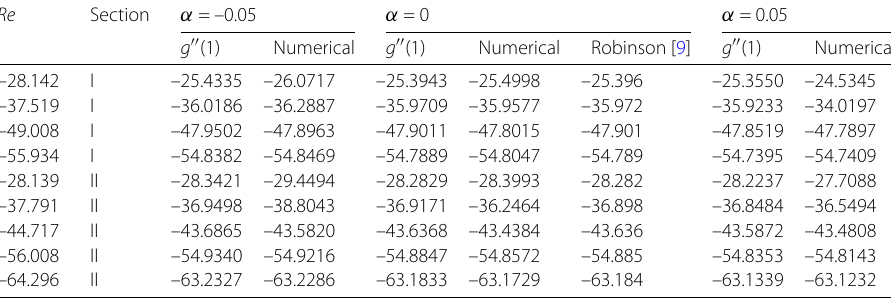
Table 2 Numerical values of g (cid:3)(cid:3) ( η ) at η = 1 for various values of Re compared with the analytic results obtained from (91) with the exponentially small correction